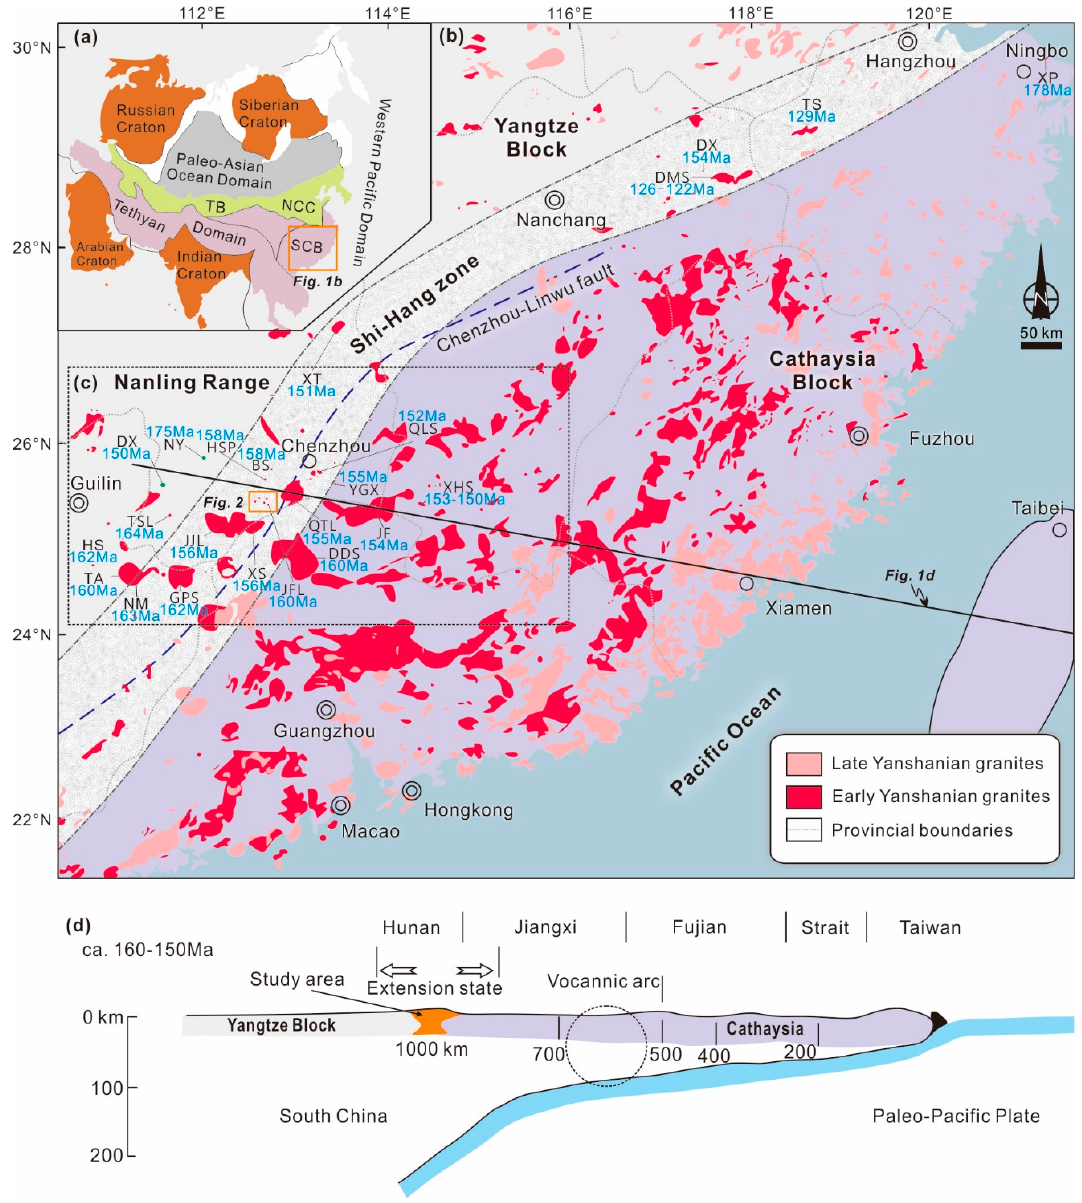
Figure 1. ( a ) Simplified tectonic map of Asia showing the framework of the joint area of the Paleo–Asian, Tethyan, and Pacific domains [4]. TB, Tibet Block; NCC, North China Block; SCB, South China Block. ( b ) Distribution of the Mesozoic intrusive rocks in South China [7,15,21,24,25]. The locations of the Shi-Hang zone and Nangling range are after [19,26,27]. ( c ) Sketch map of the Nanling Range [13]. ( d ) Simplified map showing the Late Jurassic subduction in Southeast China [28]. NM, Niumiao granodiorite [29]; TA, Tong’an monzonite [29]; HS, Huashan granite [30,31]; GPS, Guposhan granite [30,31]; TSL, Tongshanling granodiorite [19,32]; JJL, Jinjiling granite [19,33]; XS, Xishan granite [33]; DDS, Dadongshan granite [34]. JFL, Jianfengling (our no published data); DX, Daoxian basalt [19,35]; NY, Ningyuan basalt [19,35]; QTL, Qitianling granite [36]; HSP, Huangshaping granite [37]; BS, Baoshan granodiorite [32,38]; JF, Jiufeng granite [39,40]; QLS, Qianlishan granite [41]; YGX, Yaogangxian granite [42]; XHS, Xihuashan granite [43,44]; XT, Xitian granite [15]; DMS, Damaoshan granite [45]; DX, Dexing granodiorite [46]; TS, Tongshan granite [45]; XP, Xiepu granite